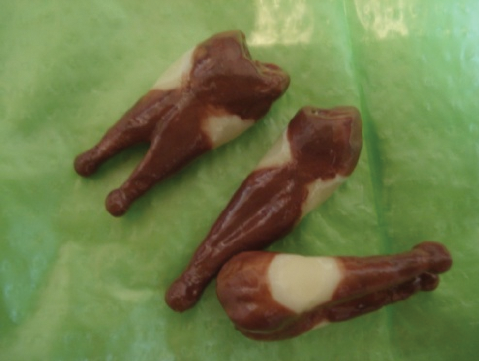
Figure 1. The teeth were coated with nail varnish up to 1mm of restoration